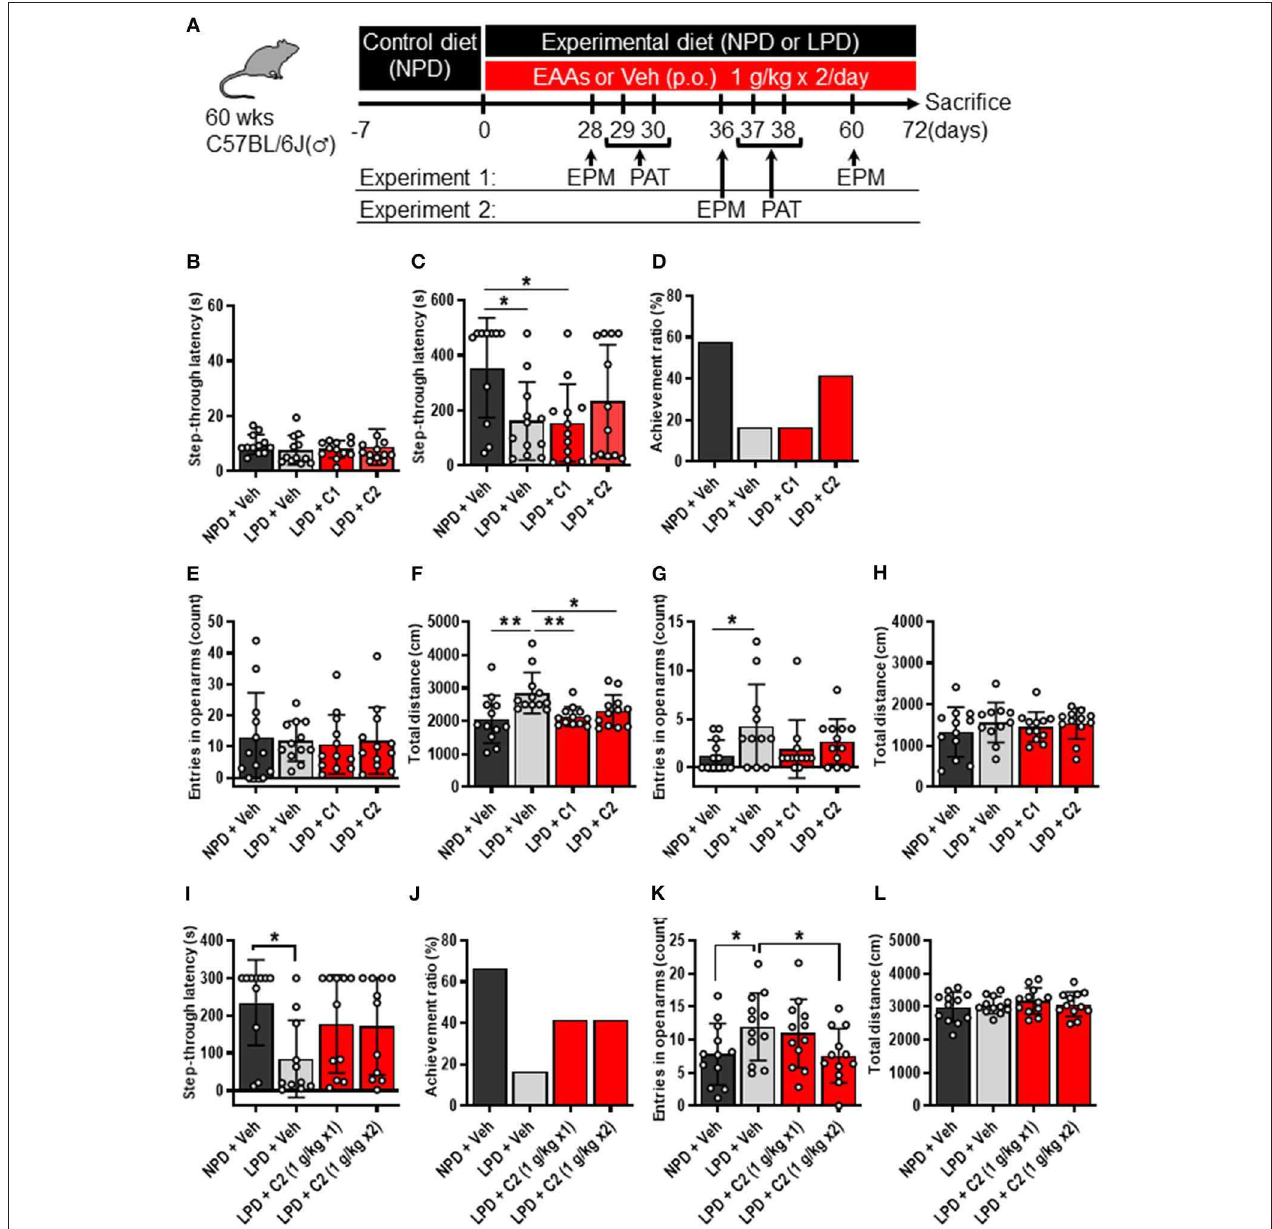
FIGURE 1 | LPD induced cognitive decline, agitation, and disinhibition behavior, but EAAs ameliorated these changes. (A) Schematic diagram of the experimental procedure. Experiment 1 data are shown in (B–H) . (B–D) Summary of PAT results. (B) During the training session, there was no significant difference among the groups. (C) Mean step-through latency in each group during the training trial [F (3, 43) = 3.4, p < 0.05]. The latency time was significantly lower in the LPD + Veh group than in the NPD + Veh group (* p < 0.05) and in the LPD + C1 group than in the NPD + Veh (* p < 0.05) but not in the LPD + C2 group compared with that in the NPD + Veh group. (D) Summary of the achievement ratio which is the effect of the 1st electrical stimulation (ES) on step-through latency in each group. (E–H) Summary of EPM test results on day 28 (E,F) and day 60 (G,H) . (E) Mean number of entries in the open arms on day 28 in each group. There was no significant difference among the groups. (F) Mean total distance traveled on day 28 in each group [F (3,44) = 5.0, p < 0.01]. The total distance was significantly increased in the LPD + Veh group compared with that in the NPD + Veh group (** p < 0.01, Holm-Sidak’s test), in the LPD + Veh group compared with that in the LPD + C1 group (** p < 0.01, Holm-Sidak’s test), and in the LPD + Veh group compared with that in the LPD + C2 group (* p < 0.05, Holm-Sidak’s test). (G) Mean number of entries in the open arms on day 60 in each group ( p < 0.05, Bartlett’s test). The number of entries in the open arms was significantly higher in the LPD + Veh group than in the NPD + Veh group (* p < 0.05, Dunnett’s test). (H) Mean total distance traveled on day 60 in each group. There was no significant difference among the groups. Experiment 2 data are shown in (I–L) . (I,J) Summary of PAT results. (I) Mean step-through latency in each group during the training trial [F (3,40) = 2.9, p < 0.05]. The latency